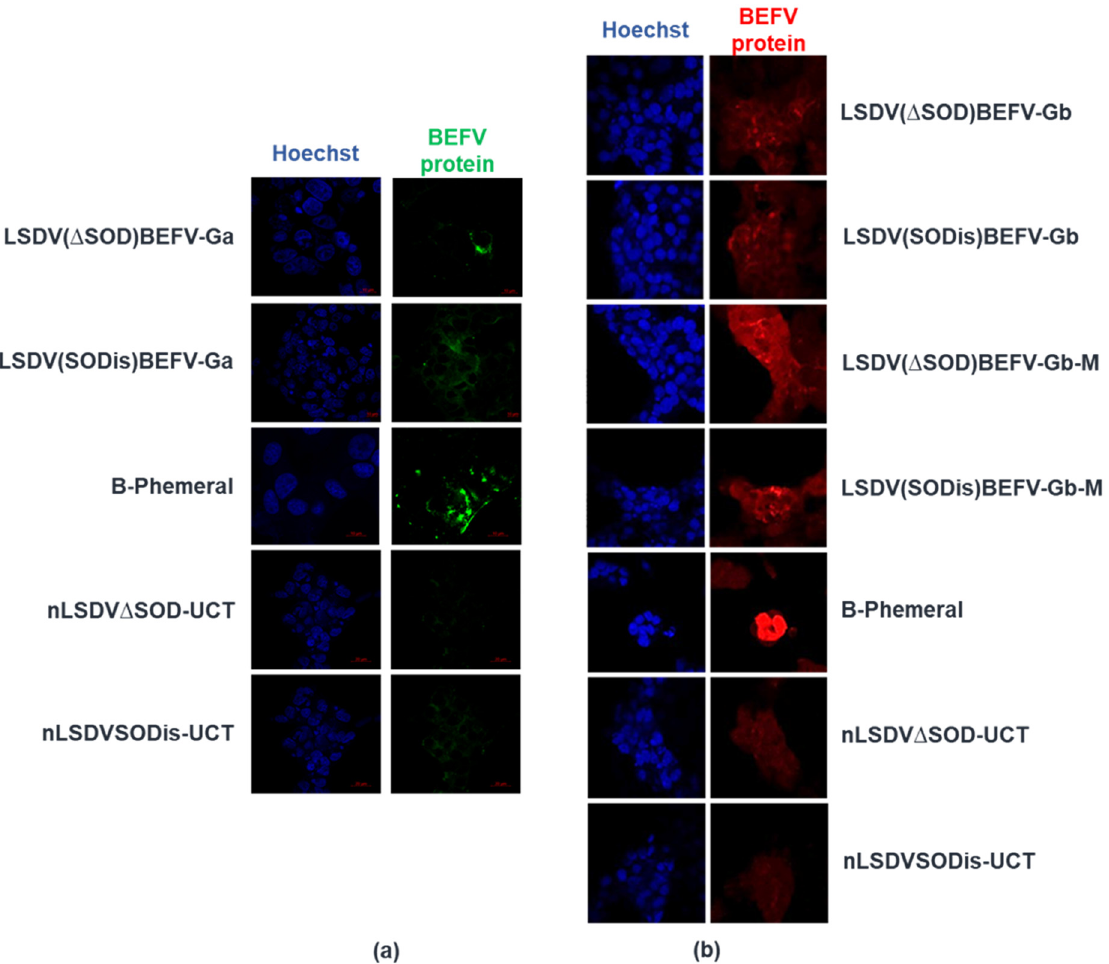
Figure 4. BEFV protein expression detected by immunofluorescence. MDBK cells grown on chamber slides were infected with B-Phemeral (positive control) and each of the vaccines at an MOI of 0.1 for 48 h. The two parent LSDV vaccines (nLSDV ∆ SOD-UCT and nLSDVSODis-UCT) were used as negative controls. Anti-B-Phemeral rabbit serum was used as the primary antibody for all samples (1:1000 dilution). ( a ) detection of BEFV Ga expression (green) using donkey anti-rabbit Alexa488 secondary antibody (1:500); ( b ) detection of BEFV Gb (red) and BEFV-Gb-M (red) using anti-rabbit CY3 secondary antibody (1:500). Nucleic acid was stained with Hoechst (blue).